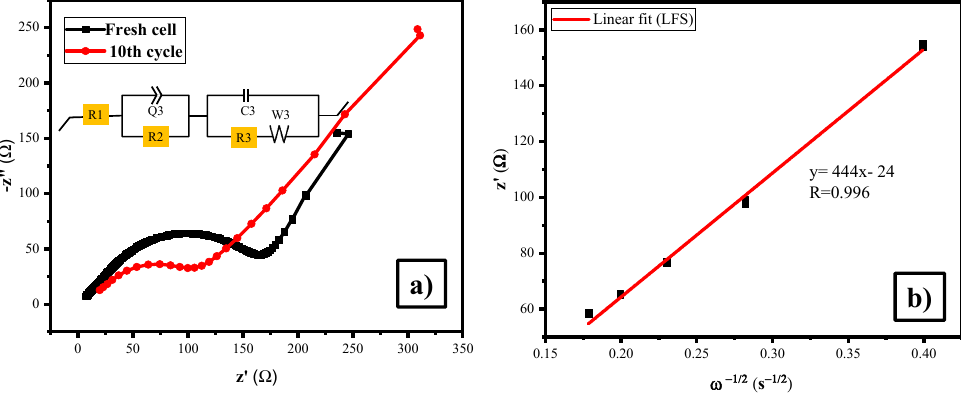
Figure 5. ( a ) Cyclic performance and ( b ) galvanostatic charge discharge profile of Li 2 FeSiO 4 /C.